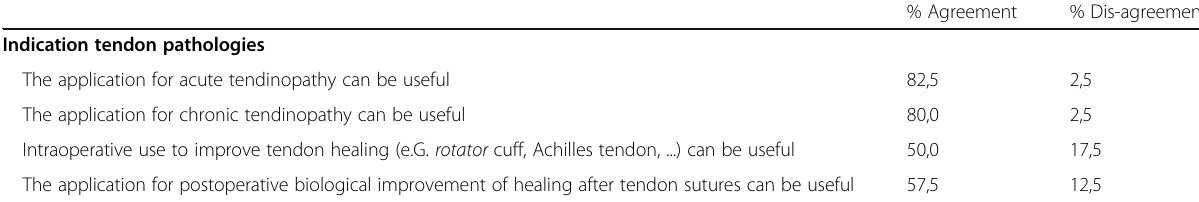
Table 2 Indication for use of PRP in tendon pathologies